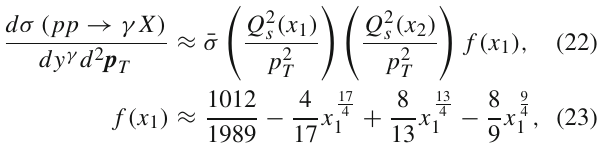
Fig. 2 Differential cross sections for prompt photon production in pp collision at are obtained using three phenomenological CD models and compared to the experimental data from CMS experiment